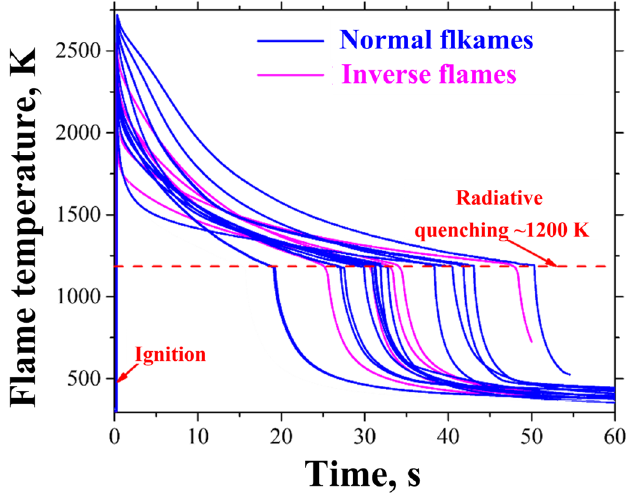
Figure 6. Calculated time histories of the temperature of normal and inverse flames undergoing radiative extinction.